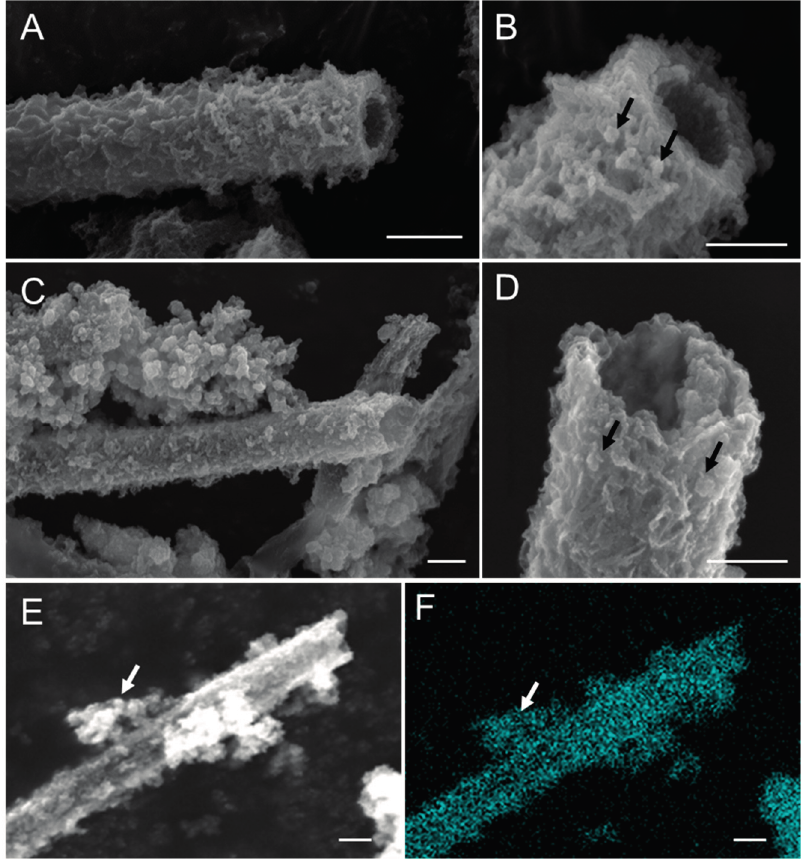
Figure 3. SEM and EDX mapping images of sheaths formed in Fe plate and -powder media during two week incubation. A, B: Sheath with fibrous outer surface ( A ) and enlarged image of sheath with a thick wall ( B ) in Fe plate medium. C, D: Sheath with fibrous outer surface ( C ) and enlarged image of sheath with relatively thin wall ( D ) in Fe powder medium. Note fine Fe particles on the sheath surface (arrows in B and D). E, F: SEM image ( E ) and Fe distribution map ( F ) of sheath formed in Fe powder medium. Note that particles attached to the sheath surface (arrows) contain a detectable level of Fe. Scale: A, C, E, F, 1 μ m; B, D, 500